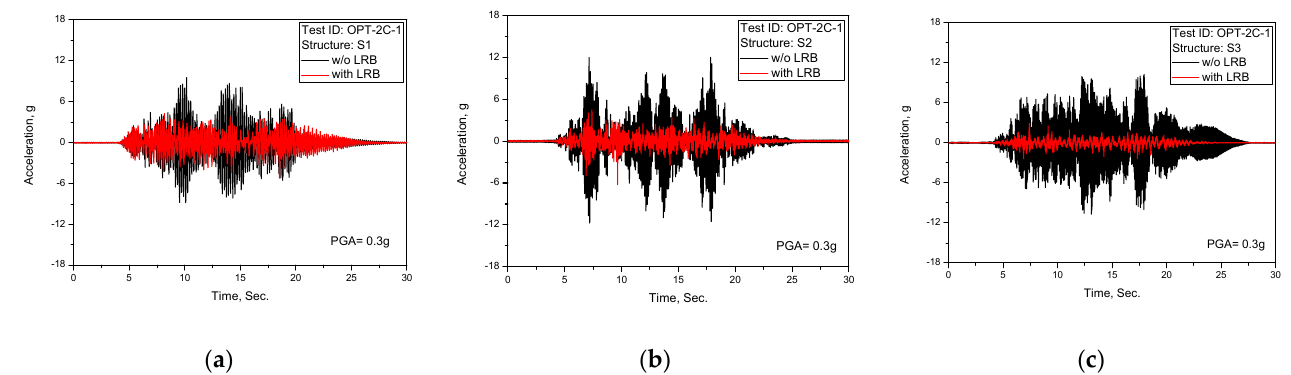
Figure 12. Test results of acceleration time history response (TEST ID: OPT-2C-1, PGA = 0.3 g): ( a ) S1; ( b ) S2; ( c ) S3.